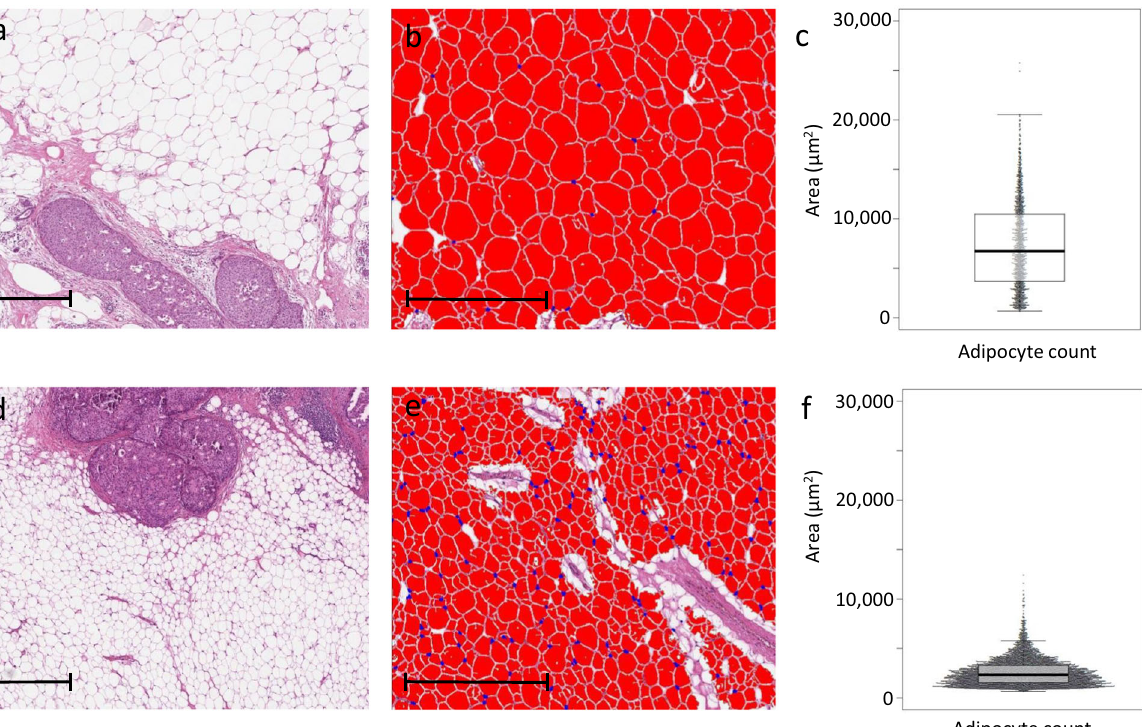
Fig. 2 Digital assessment of breast adipocyte area in two representative patients. Scale bars represent 500 µm. a A 68-year-old patient with DCIS that developed subsequent iIBC. The breast adipose tissue consists of large adipocytes. b Adipocytes were analysed with the vacuole module v2.1 (HALO software, Indica Labs, Corrales, NM, USA). c Beeswarm plot of the corresponding distribution of adipocyte area with mean adipocyte area and area 75th of 7287 and 10493 µm 2 , respectively. d DCIS surrounded by small adipocytes from a 38-year-old patient. No subsequent iIBC occurred during follow-up. e Corresponding image of analysed adipocytes in HALO software. f Beeswarm plot of the corresponding distribution of adipocyte area with mean adipocyte area and area 75th of 2593 and 3274 µm 2 , respectively.